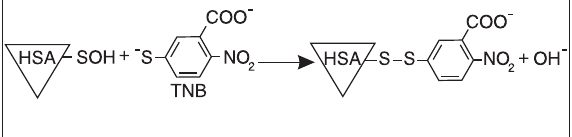
Figure 3. Reaction of albumin sulfenic acid (HSA-SOH) with thionitrobenzoate